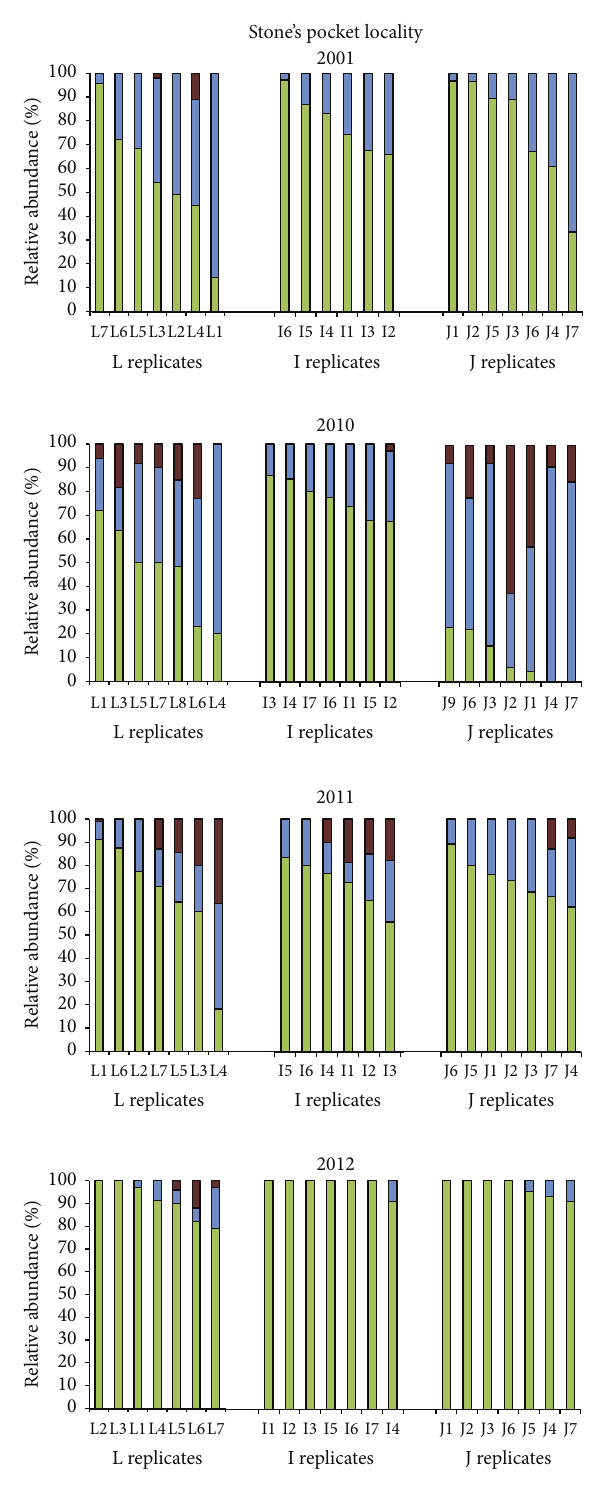
Figure 5: Relative abundance of different taxa at Stone’s Pocket measured by 1D TRFLP-SSCP. Stone’s Pocket soil samples from plots L, I, and J were grouped according to plot and year. Soil samples within each plot are ordered according to the relative abundance of g Ca. Nitrososphaera ( I .1 b ) . Colors represent different taxa: the darkest color, red, indicates unclassified Archaea, the midtone color, blue, indicates o NRP-J ( I .1 c ) , and the lightest color, green, indicates g Ca. Nitrososphaera ( I .1 b )